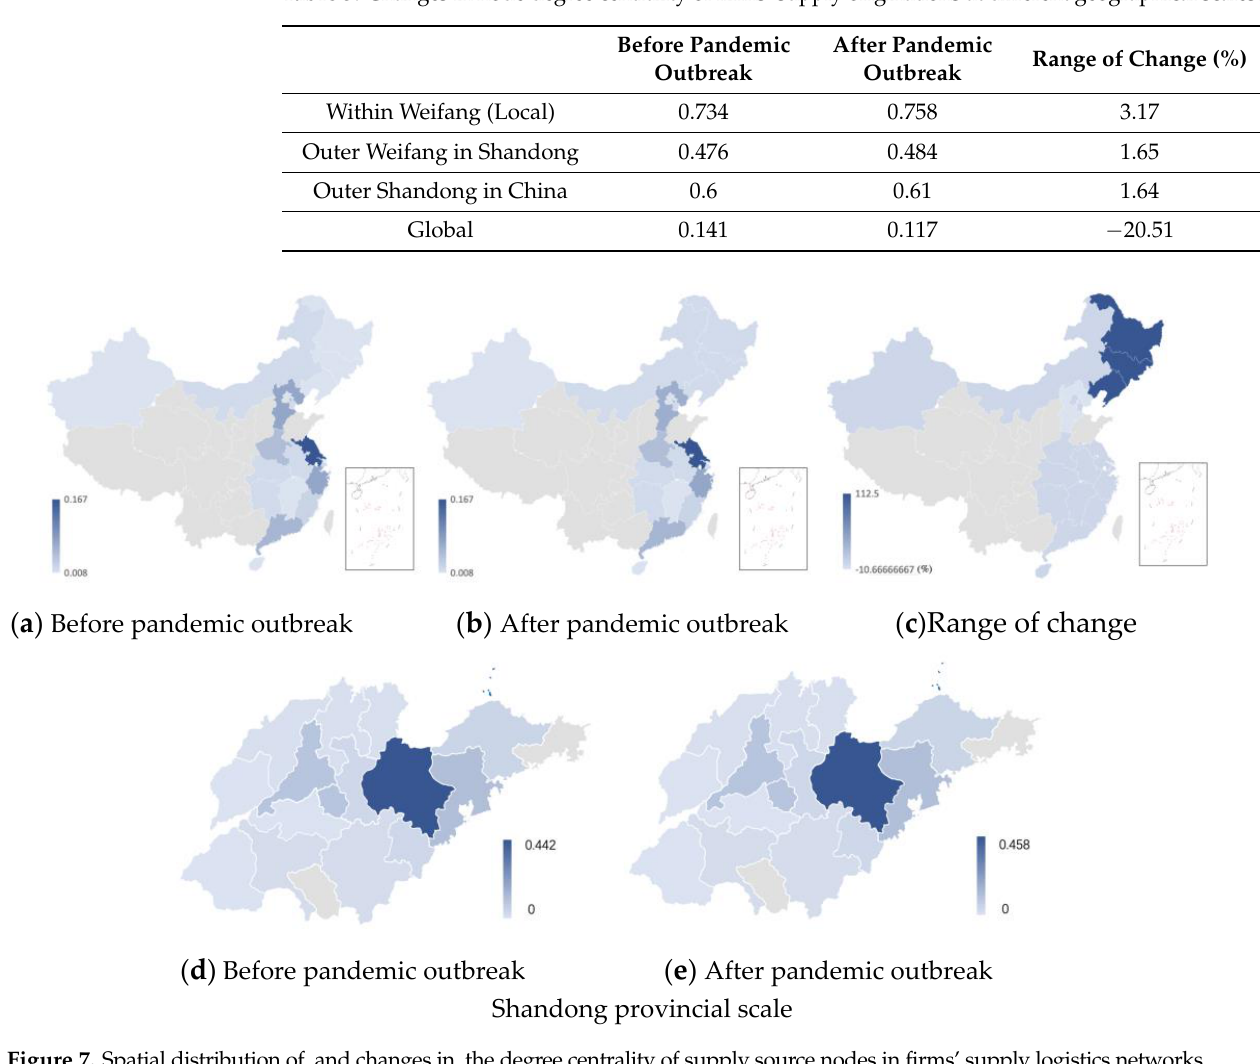
Figure 7. Spatial distribution of, and changes in, the degree centrality of supply source nodes in firms’ supply logistics networks.